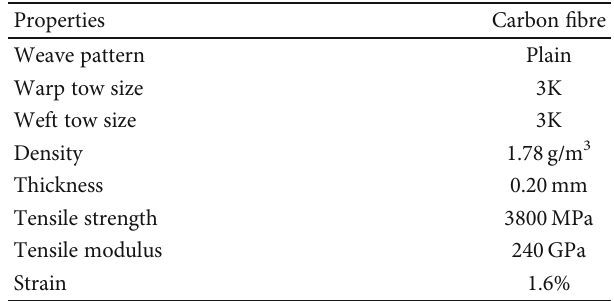
Table 1: Properties of carbon fi bre supplied by Spinteks Tekstil Ins.